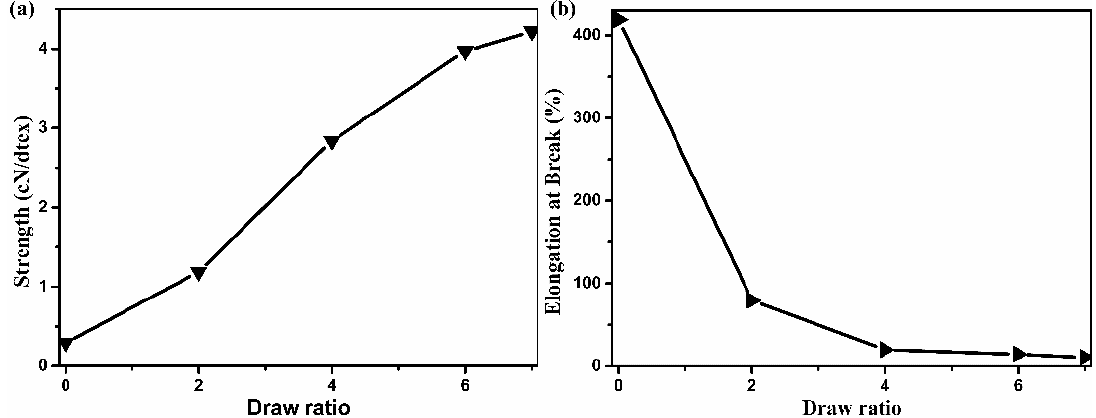
Figure 7. The tensile strength ( a ) and the elongation at break ( b ) of PVA triangular fibers at different draw ratios.